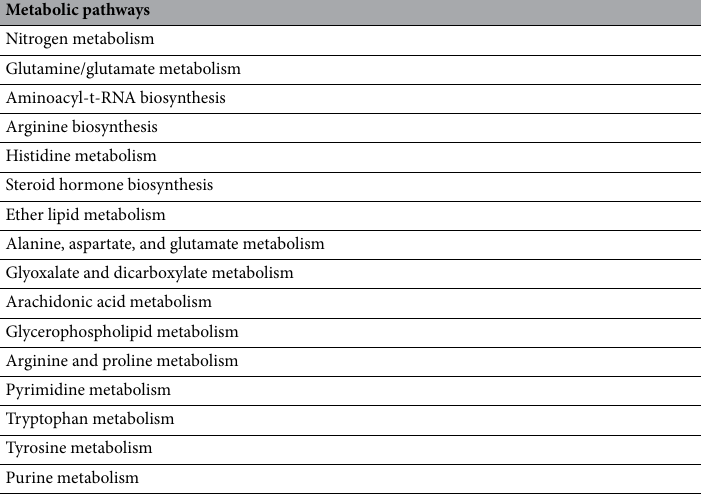
Table 3. Diverse biological processes are influenced by the perturbed metabolites specific for the BECO cancer group. Metabolanalyst software (https:// www. metab oanal yst. ca/) was used for extracting the list of biological processes associated with metabolites of interest. Briefly, the set of 25 metabolite names were added to the metaboanalyst software which cross referenced it to KEGG pathways database and HMDB database to get KEGG and HMDB ids respectively of input metabolites. Following this, the associated biological processes were